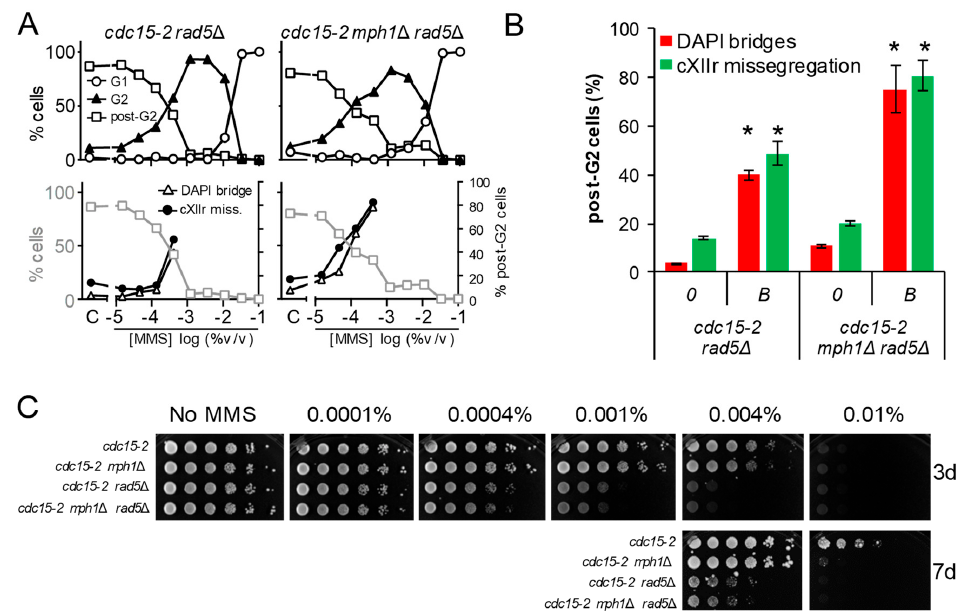
Figure 6. Deletion of MPH1 synergistically increases the post ‐ G2 aberrant figures observed in rad5 Δ . ( A ) MMS dose ‐ response curves of the FM588 rad5 Δ and rad5 Δ mph1 Δ mutant derivatives. ( B ) DAPI ‐ bridges and cXIIr missegregation of three independent experiments without (“0”) or with borderline (“ B ”) MMS (mean ± SEM). B was 0.0004% v/v for both strains. Asterisks (*) highlight the comparisons of percentages of DAPI bridges and cXIIr missegregation between rad5 Δ and mph1 Δ rad5 Δ ( p < 0.05, Student’s t test). (C) Long ‐ term survival (spotting assay) for the referred mutants under increasing